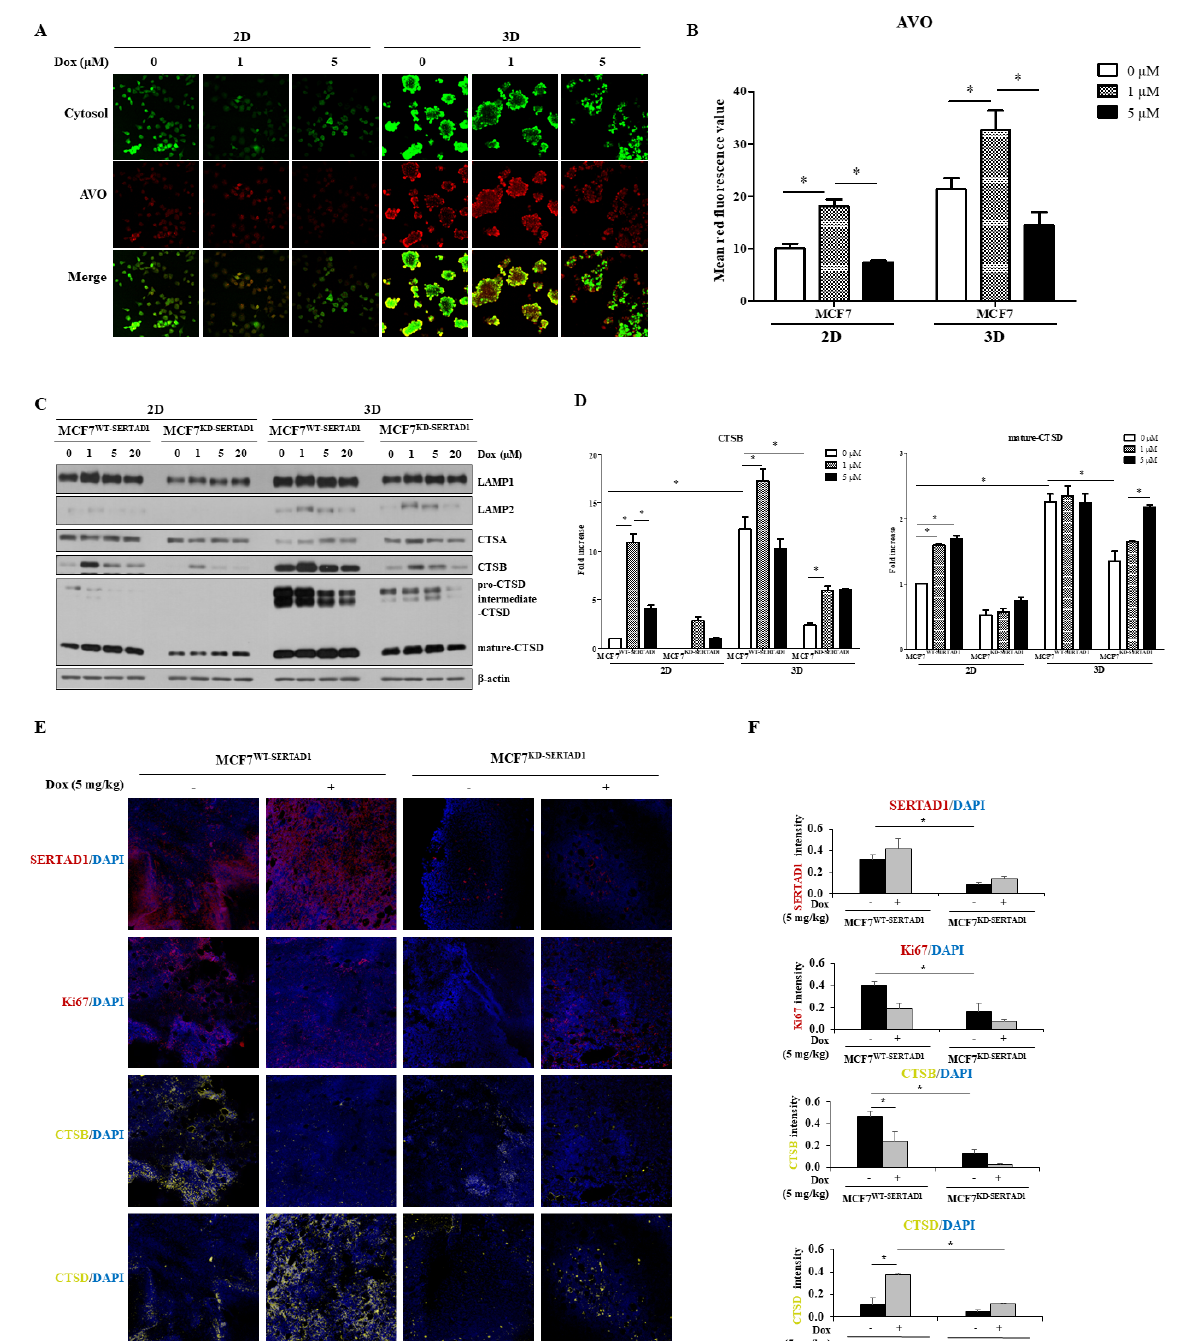
Figure 5. Effects of SERTAD1 on LMP induction and regulation of lysosomal hydrolases. ( A , B ) effect of Dox on lysosome integrity in MCF7 cells using AO staining. Cells were cultured in 2D and 3D conditions and then treated with indicated concentrations of Dox before being subjected to AO staining. AVOs per cell were analyzed using ImageJ. Images were randomly taken per plate. Data are representative of three independent experiments (n = 3). * p < 0.05. ( C , D ) Promoting role of SERTAD1 on lysosomal proteins. Total cellular extracts were prepared and expression levels of several lysosomal proteins, including LAMP1, LAMP2, CTSA, CTSB, and CTSD, were examined by immunoblotting. β -actin was used as the loading control. Blotting images and data are representative of at least three independent experiments with similar patterns. ( E , F ) Effect of SERTAD1 and Dox treatment on tumor growth and expression of CTSB and CTSD using IF staining. Images were randomly taken. Data are representative of at least three tumor samples. * p <